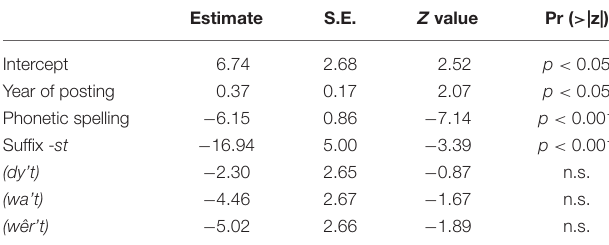
TABLE 8 | Optimal model for substitution of Frisian relative pronouns dy’t , dêr’t , wêr’t, and wa’t in Twitter data for FreqvarM, Twitterers who moderately produced the variable (range = 23–88) in their tweets) ( n = 1,293, N = 27).